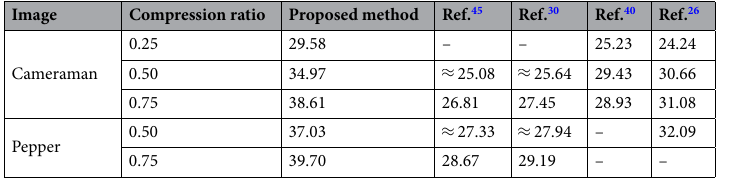
Table 2. PSNR (dB) values of the encrypted images with different approaches for the different compression